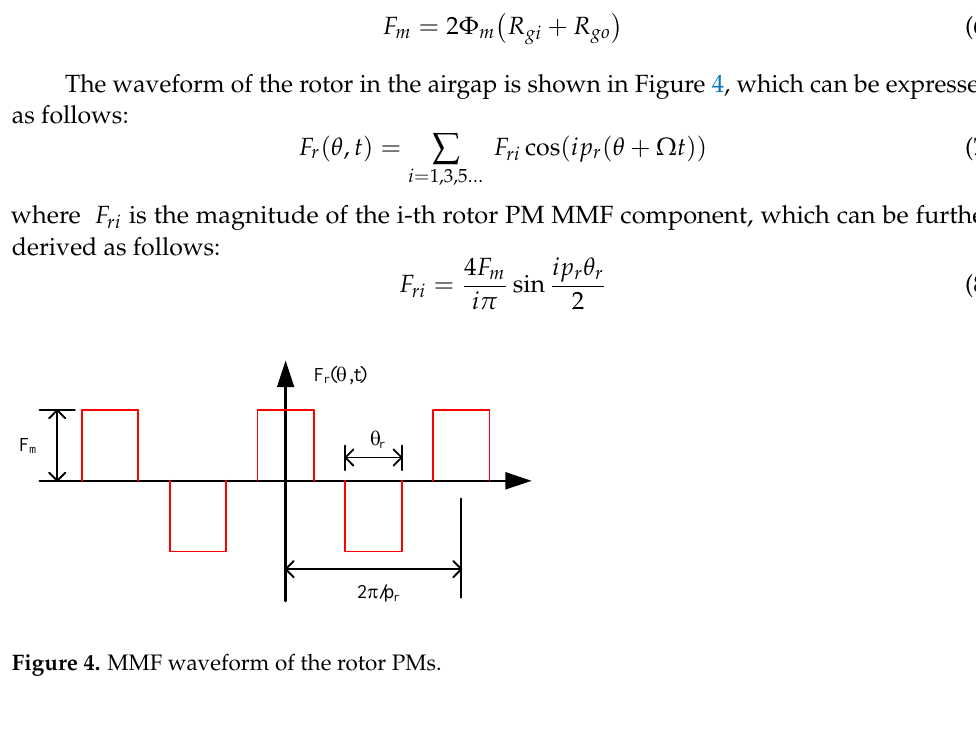
L 0 Figure 5. Permeance waveform of the modulator. The airgap flux density produced by the rotor PMs and the modulator teeth can be deduced by multiplying (7) and (9) and is expressed as follows: 𝐵 𝑟 (𝜃, 𝑡, 𝜙) = 𝐹 𝑟 (𝜃, 𝑡)Λ(𝜃, 𝜙) = 𝐵 𝑟1 (𝜃, 𝑡) + (𝐵 𝑟2 (𝜃, 𝑡, 𝜙) + 𝐵 𝑟3 (𝜃, 𝑡, 𝜙))